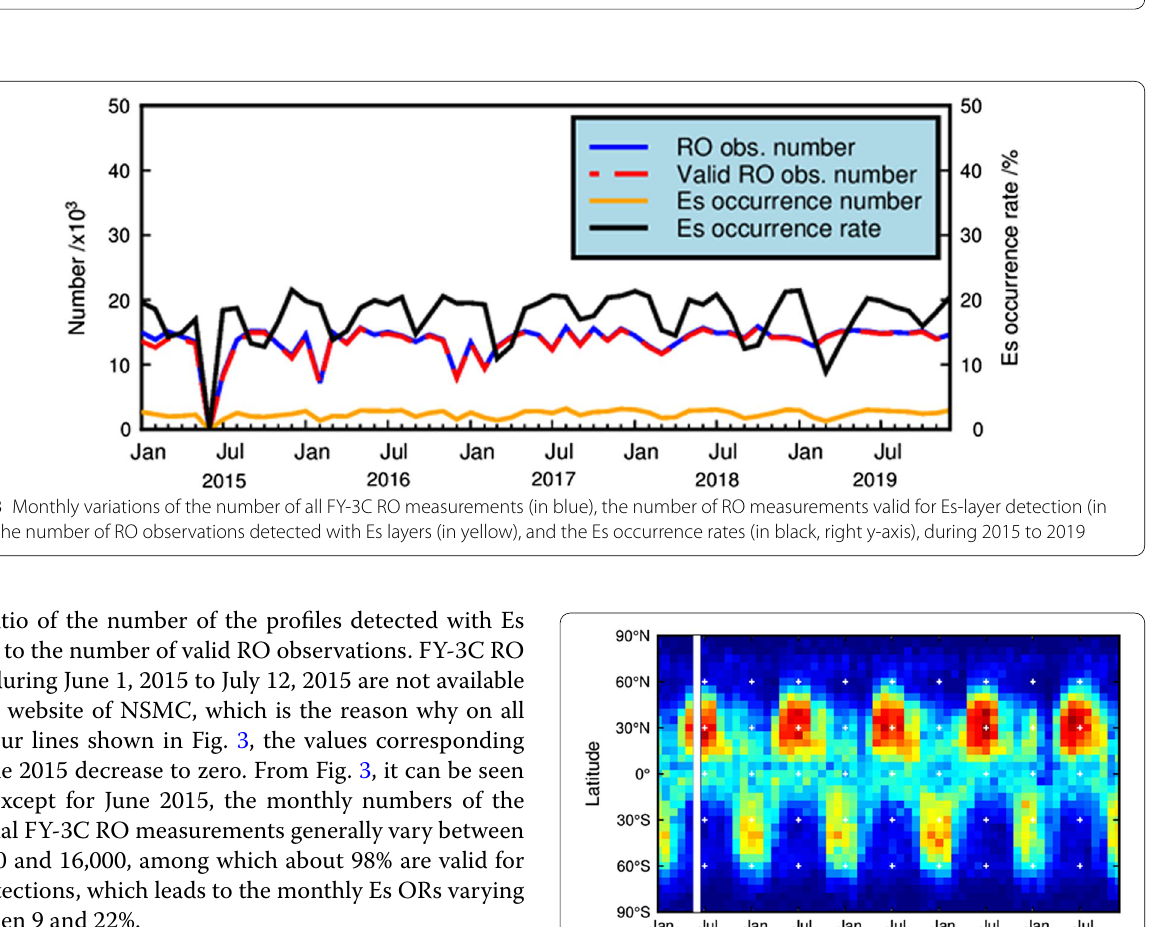
Fig. 2 Spatial distribution of the numbers of a all FY-3C RO 50-Hz observations and b FY-3C RO observations with Es events, which are binned within a grid of 5° 5° for the period from January 2015 to December 2019. The pink curve represents the geomagnetic equator and the red curves × represent the geomagnetic inclination isolines